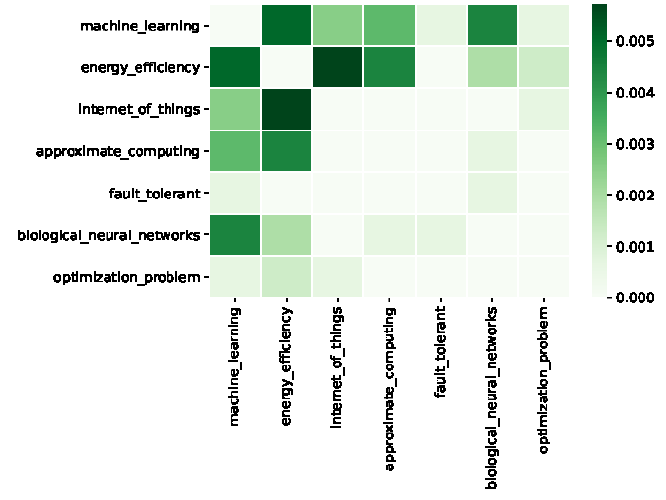
Figure 2. Heatmap visualization of the co-occurrence matrix M .